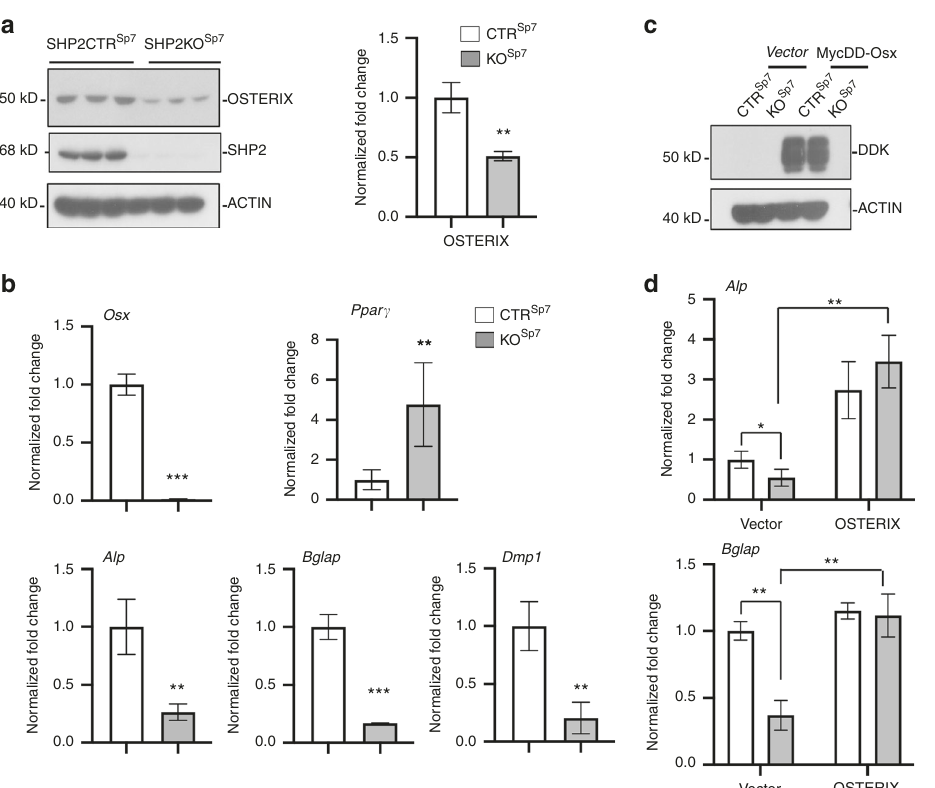
Fig. 5 SHP2 regulates osteogenic differentiation by in fl uencing OSTERIX expression. a Western blots show the expression level of OSTERIX in SHP2-suf fi cient and SHP2-de fi cient OBs, with quantitative data shown as bar graphs on the right. ACTIN served as an internal loading control. b Bar graphs show the transcript abundance of the indicated osteogenic and adipogenic genes in control and SHP2-de fi cient OBs determined by qRT-PCR ( n = 3, ** P < 0.01, *** P < 0.001, Student ’ s t -test). c Western blots show the expression of the vector and MycDD-OSTERIX in transiently transfected SHP2CTR Sp7 and SHP2KO Sp7 OBs. The transfection ef fi ciency was evaluated by immunoblotting against the DDK tag. d Bar graphs show the transcript abundance of Alp and Bglap in transiently transfected SHP2CTR Sp7 and SHP2KO Sp7 OBs determined by qRT- PCR ( n = 3, * P < 0.05, ** P < 0.01, Student ’ s t